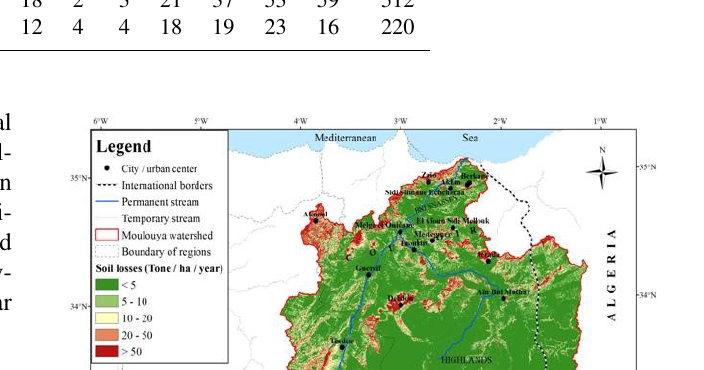
Table 1. Monthly variations in rainfall: 1963–1999 (Météorologie nationale, Oujda, Maroc). J F M A M